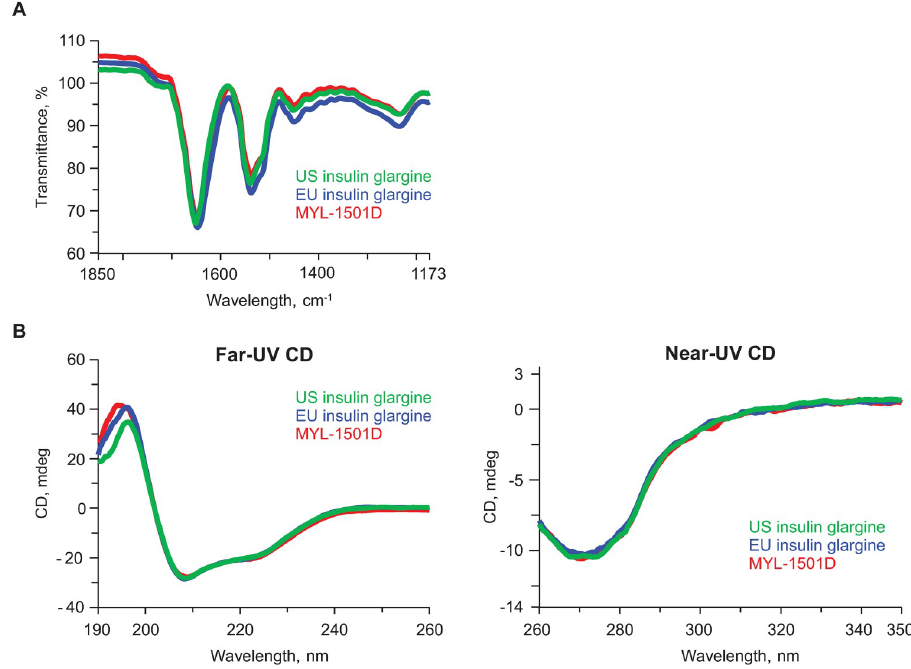
Fig 2. Representative overlay of MYL-1501D, US- and EU-licensed insulin glargine. (A) FTIR Profiles for Secondary Structure of and (B) CD Profiles for Secondary and Tertiary Structures. CD, circular dichroism; FTIR, Fourier-transformed